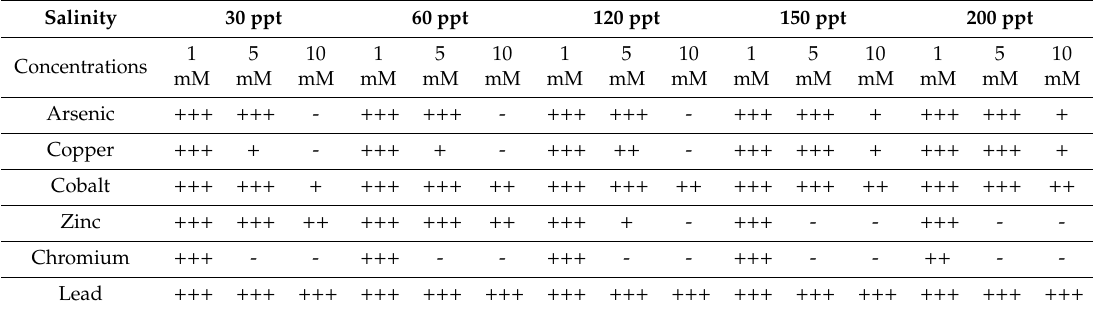
Table 3. Heavy metal tolerance of Salinivibrio sp . under di ff erent salinity. Salinity 30 ppt 60